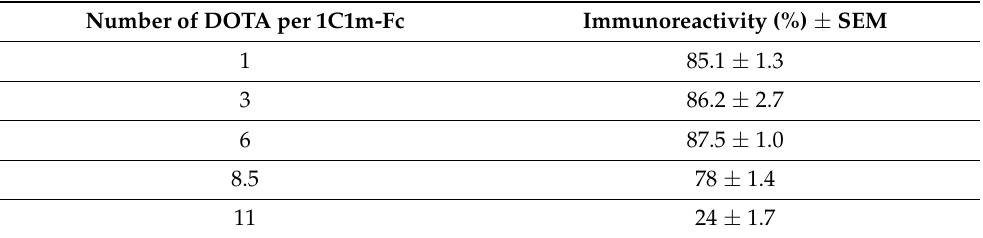
Table 2. Radioimmunoreactive fraction results for [ 177 Lu]Lu-1C1m-Fc conjugated with 1 to 11 DOTA. Number of DOTA per